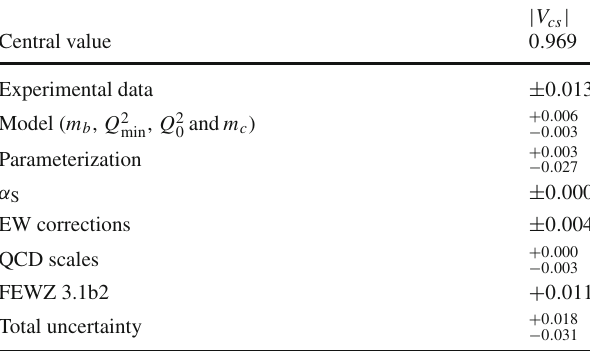
nations of | V cs | extracted from leptonic D s meson